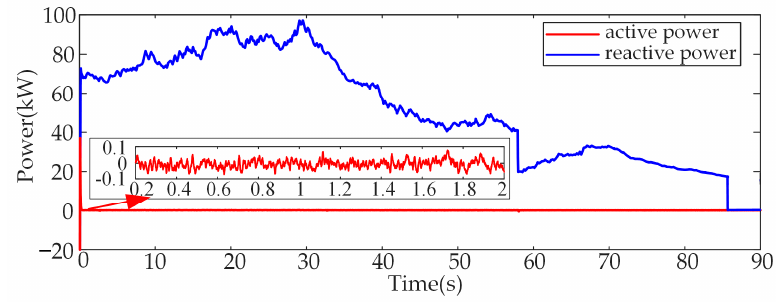
Figure 22. Grid ‐ connected power. Figure 22. Grid-connected power.